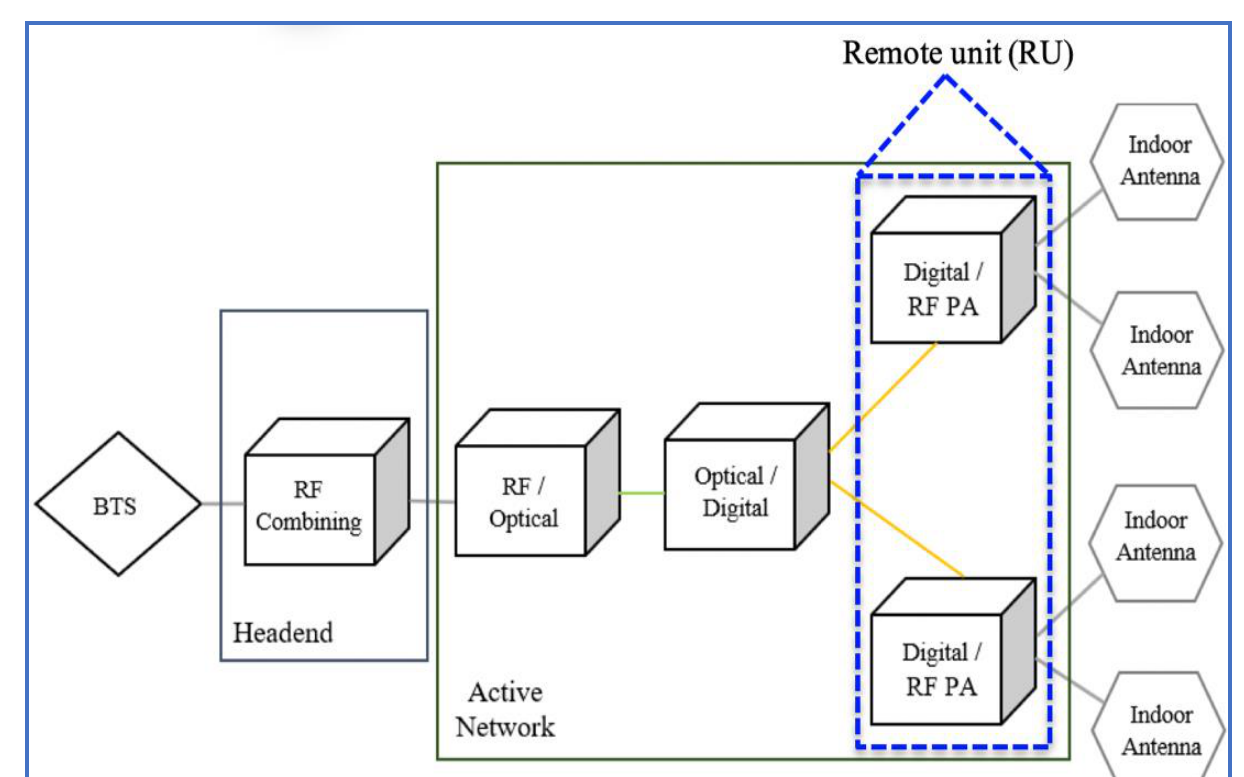
Figure 1. A block diagram of an indoor distributed antenna.